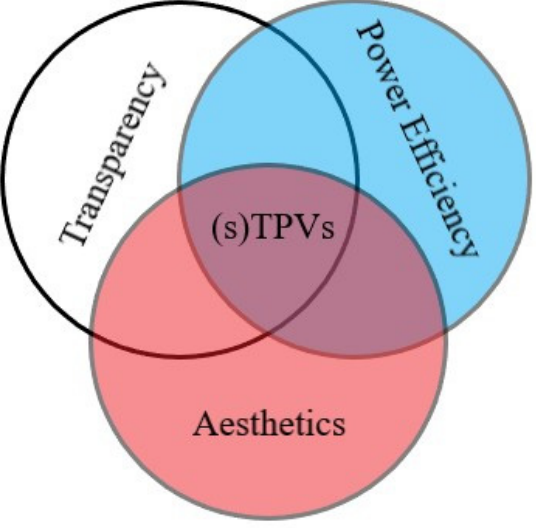
Figure 1. Visual schematisation of the three key factors in the design of TPVs and sTPVs. Another key characteristic relevant to TPVs and sTPVs is their ability to accurately transmit colours, especially for windows and vehicle applications. This is measured by their colour rendering index (CRI), which quantifies the accuracy with which an object’s colour is rendered from a light source or through a transparent medium, compared to a reference light source (e.g., a black body at a certain colour temperature). For window applications, the AM1.5G spectrum is considered to be the best standard to use [6]. CRI can assume values from 0 to 100, with higher values representing more accurate colour- rendering capabilities (Figure 2): a light source with a CRI of 70–90 is considered to be of good quality [15] and the same is true for TPVs or